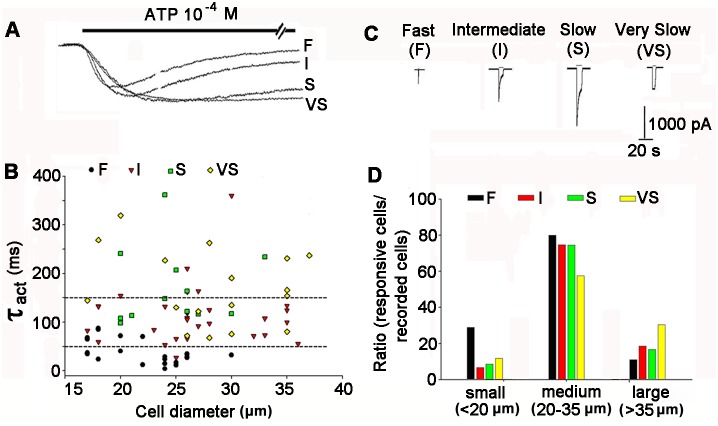
Four types of IATPs and their relationship with NG neuron diameter.(A) The currents activated by ATP (10−4 M) in NG were characterized according to fast (F), intermediate (I), slow (S), and very slow (VS) kinetics with an expanded time axis. The horizontal bar above the traces indicates the application of ATP. (B) The 10–90% rising time (ordinate) of different types of ATP (10−4 M)-activated currents (black circles  =  type F, red triangles  =  type I, green squares  =  for type S, and yellow diamonds  =  type VS IATPs) against neuron diameter. Each point in the graph represents a single cell. The correlation coefficient was 0.66 (p<0.05). (C) Representative traces of type F, I, S, and VS ATP (10−4 M)-activated currents. (D) Comparisons of the absolute ratios of the four types of IATPs in different subpopulations (small, medium, and large sizes) of NG neurons. Specifically, F type: small (13/54, 28.9%), medium (36/54, 80.0%), and large (5/45, 11.1%); I type: small (5/75, 6.7%), medium (56/75, 74.7%), and large (14/75, 18.6%); S type: small (11/126, 8.7%), medium (94/126, 74.6%), and large (21/126, 16.7%); VS type: small (7/59, 11.9%), medium (34/59, 57.6%), and large (18/59, 30.5%).